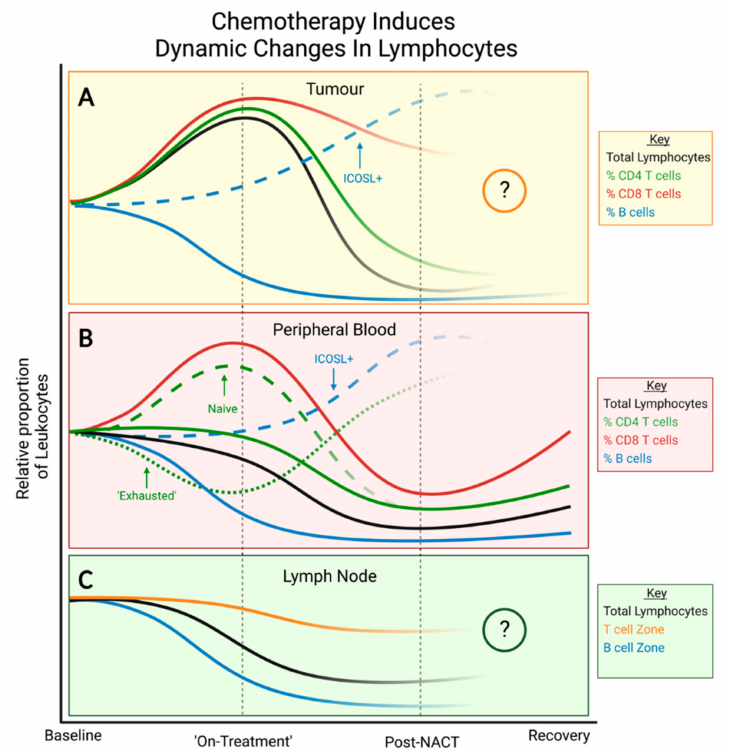
Figure 4. Immunomodulatory effects of chemotherapy during treatment. ( A ) Within an immune- infiltrated TME, proportions of CD4+ and CD8+ T cells increase initially before falling after